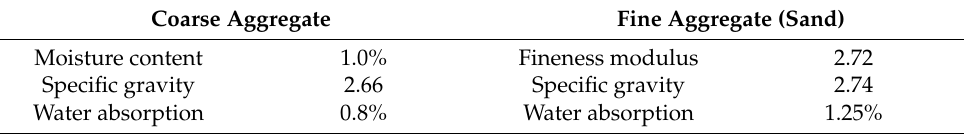
Table 4. The properties of coarse and fine aggregates.